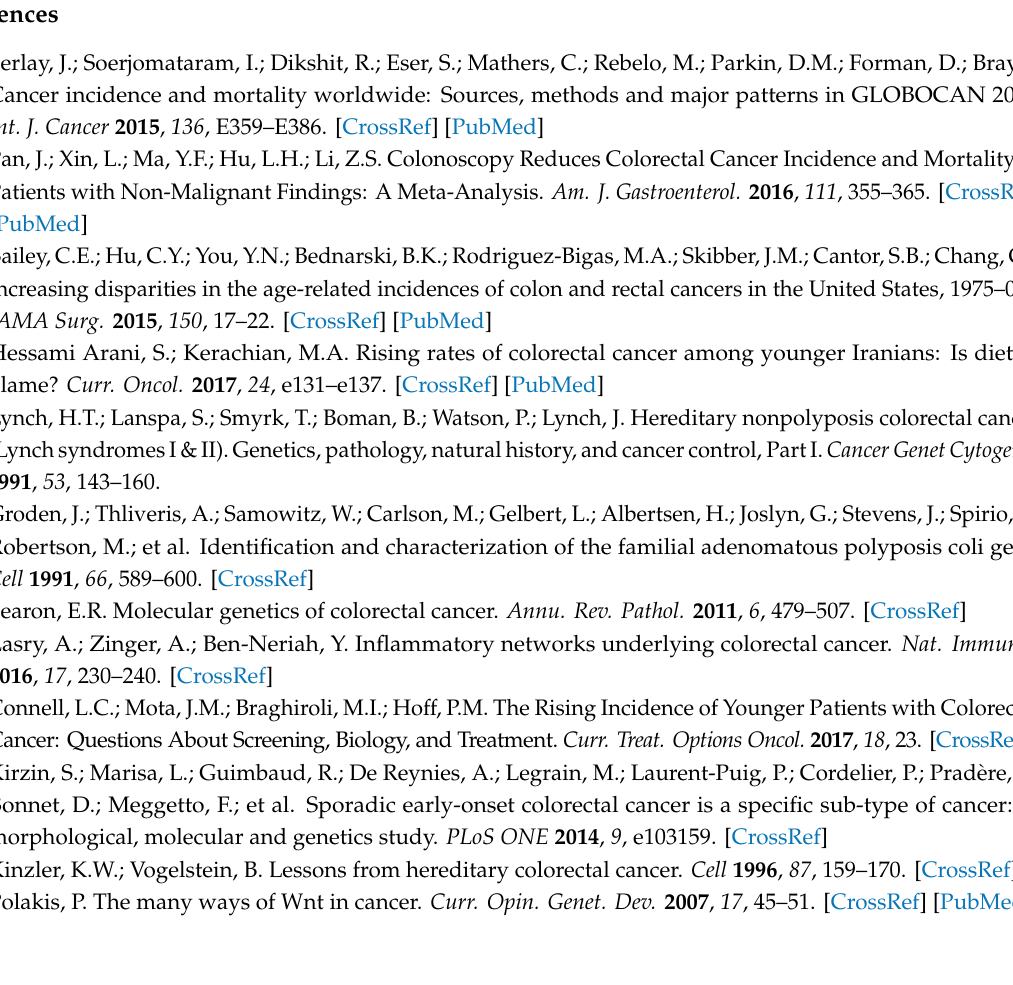
Table S1: APC amplicon specific primers for next generation sequencing, Table S2: Forward adapter primers for creating next generation sequencing libraries, Table S3: Reverse adapter primers for creating next generation sequencing